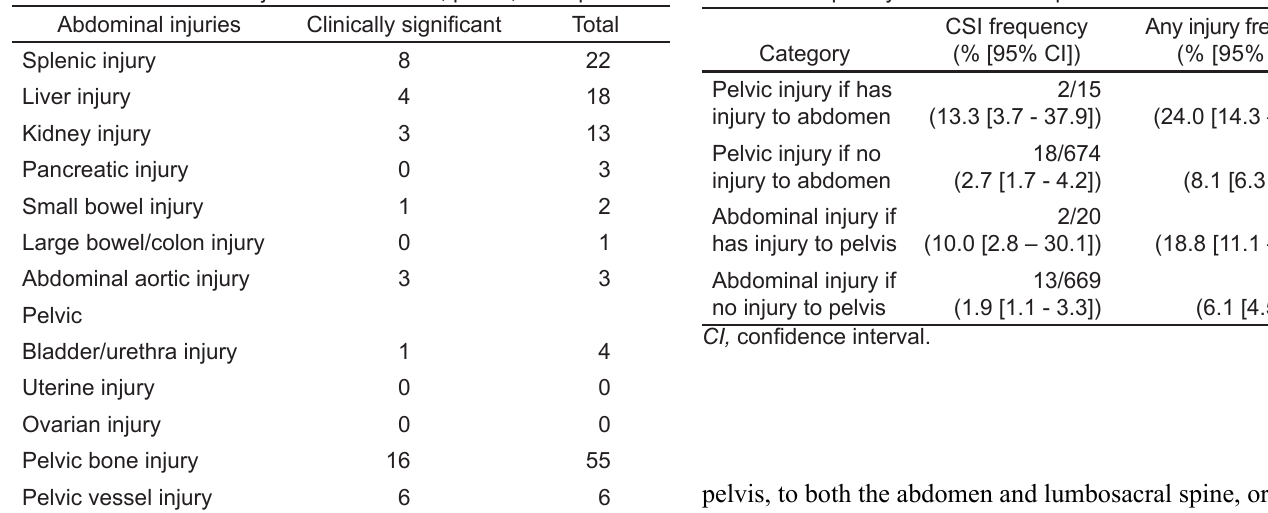
Table 5. Frequency of concomitant pelvic and abdominal injury.